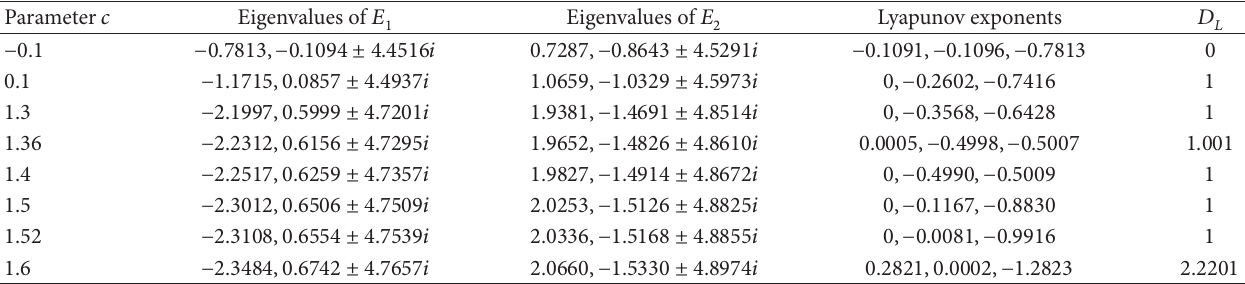
Table 1: Numerical results for some values of the parameter 𝑐 with 𝑎 = −20 , 𝑏 = 1 .